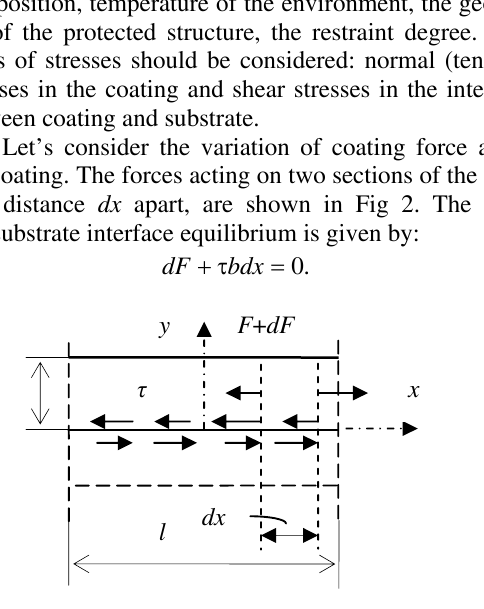
Fig 2 . Stresses on elementary strip dx of coating due to external or/and internal actions